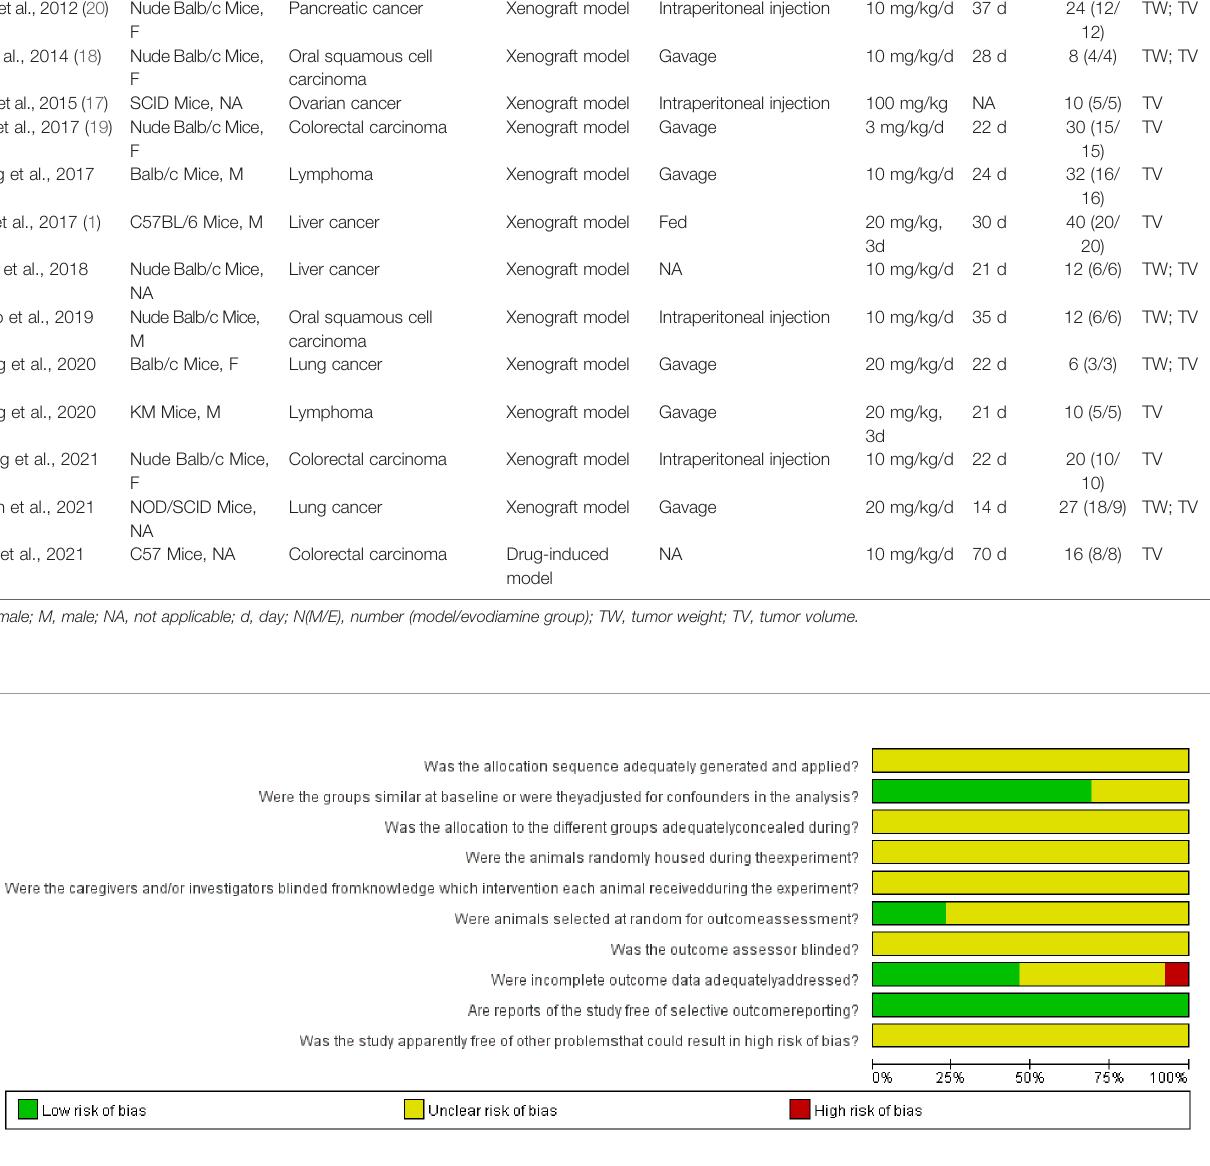
FIGURE 3 | The risk of bias graph of included